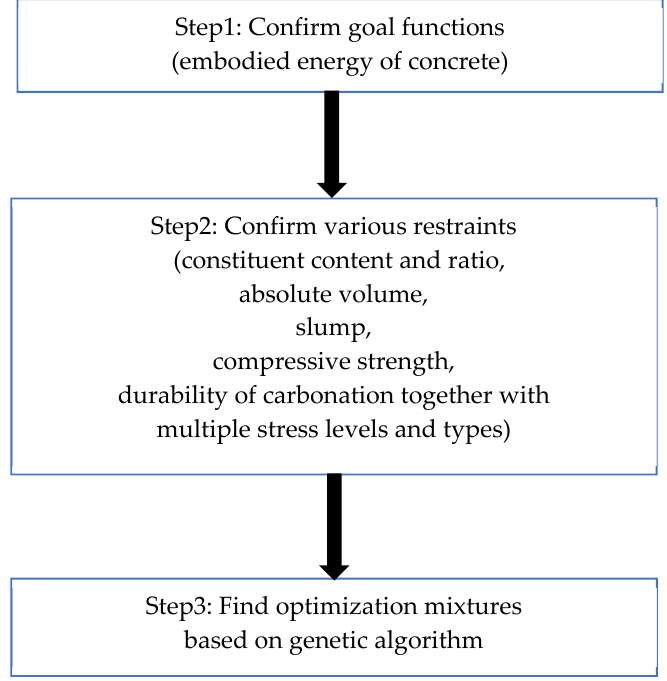
Figure 2. Flowchart of the calculation.